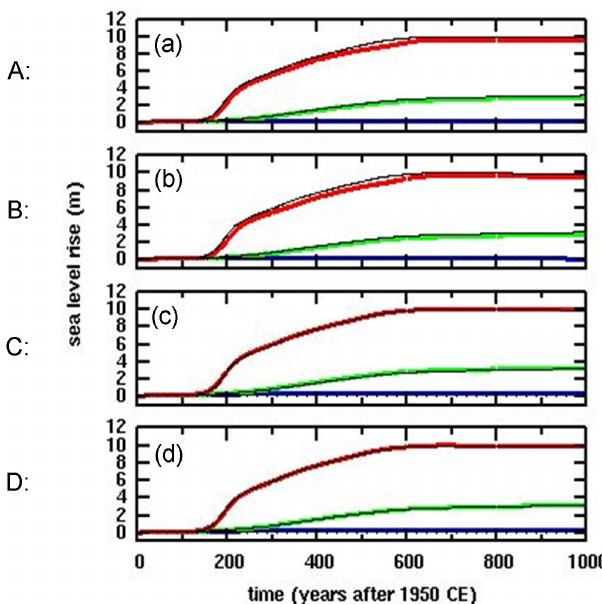
Figure A2. Equivalent global sea level rise in simulations of fu- ture West Antarctic ice retreat with climate forcing based on the RCP8.5 greenhouse-gas scenario. (a–d) With the four alternate θ methods (A to D) described in the text. Thick colored lines: as in the main paper except with one of the alternate θ methods. Thin black lines: as in the main paper with the new θ method described in Sect. 2. Blue: control (perpetual modern climate). Green: with RCP8.5 forcing, without hydrofracturing or cliff failure. Red: with RCP8.5 forcing, with hydrofracturing and cliff failure.